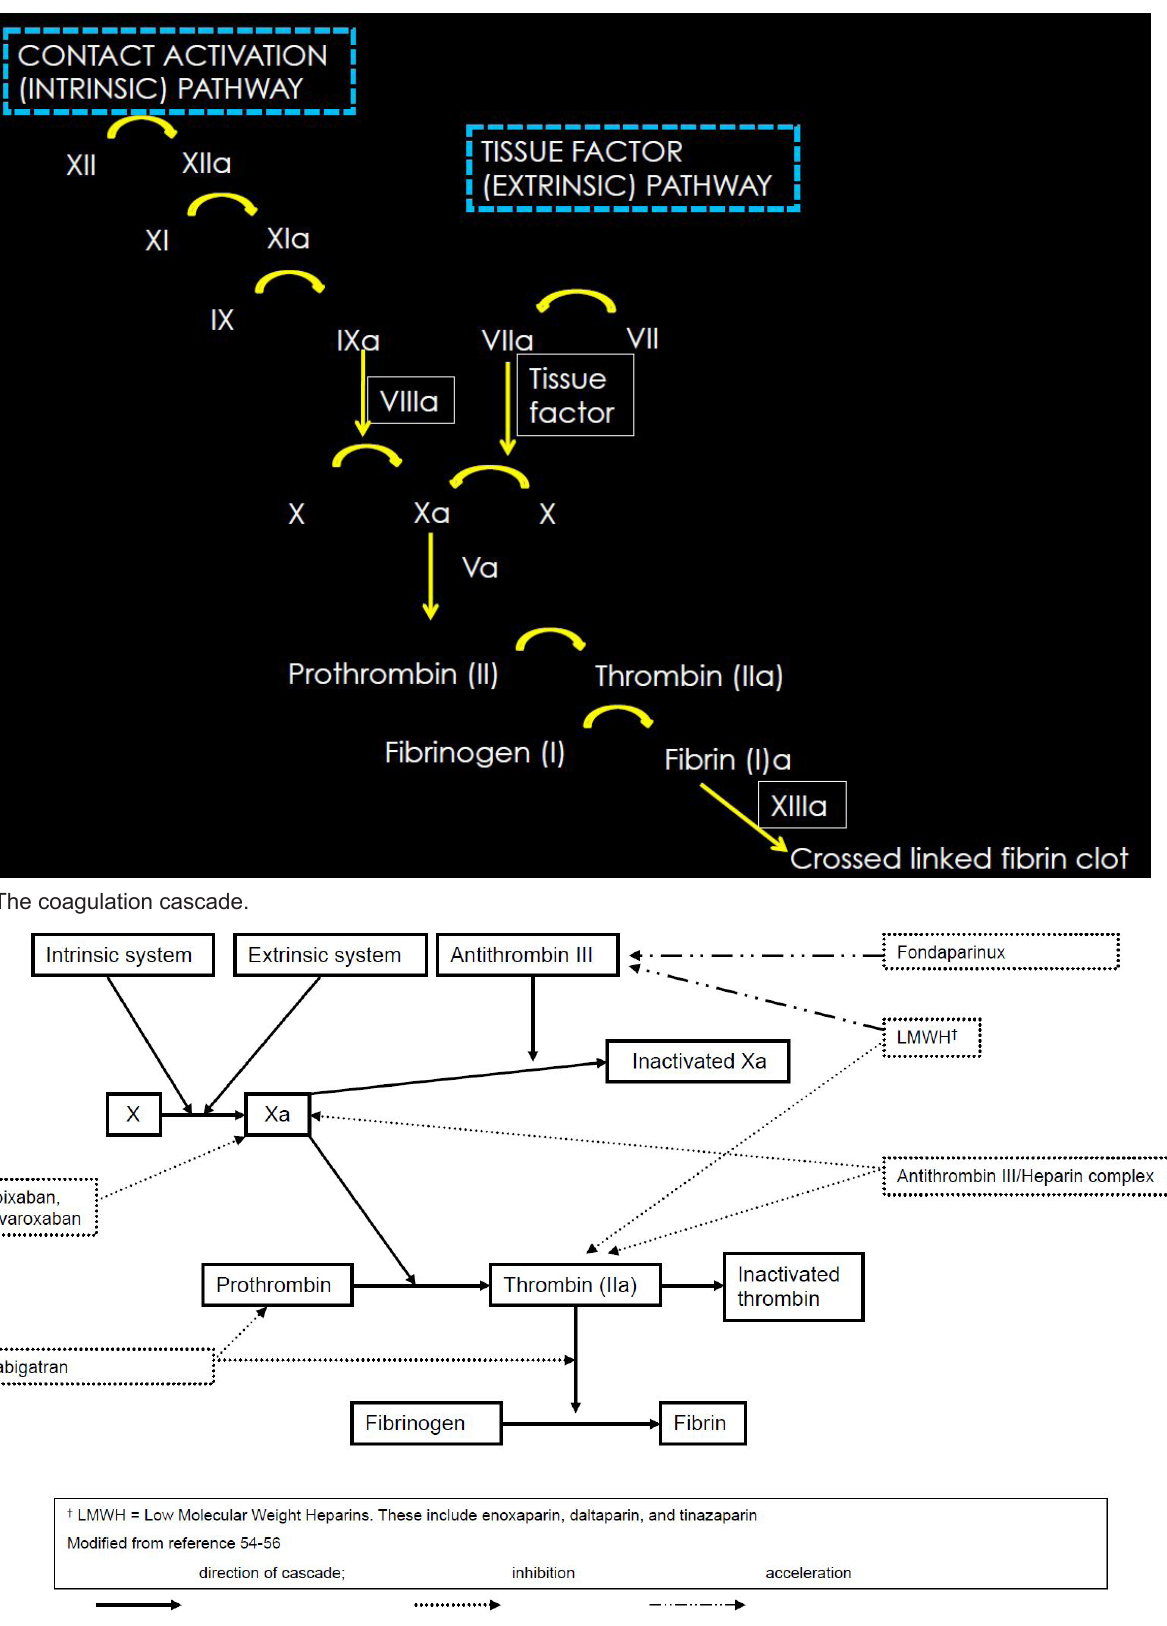
Figure 2. Site of action of drugs. Modified, with permission, Gresham C, Levine M, Ruha AM.